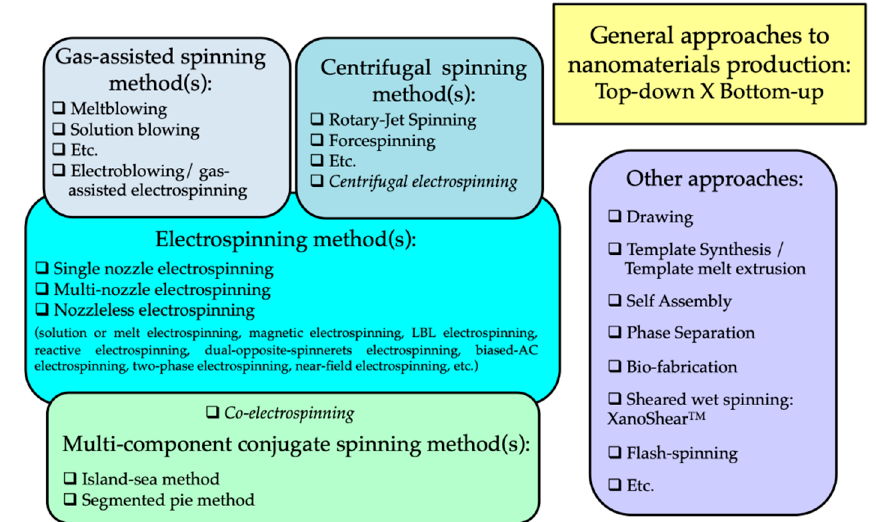
Figure 1. Classification of nanofibers-producing methods.